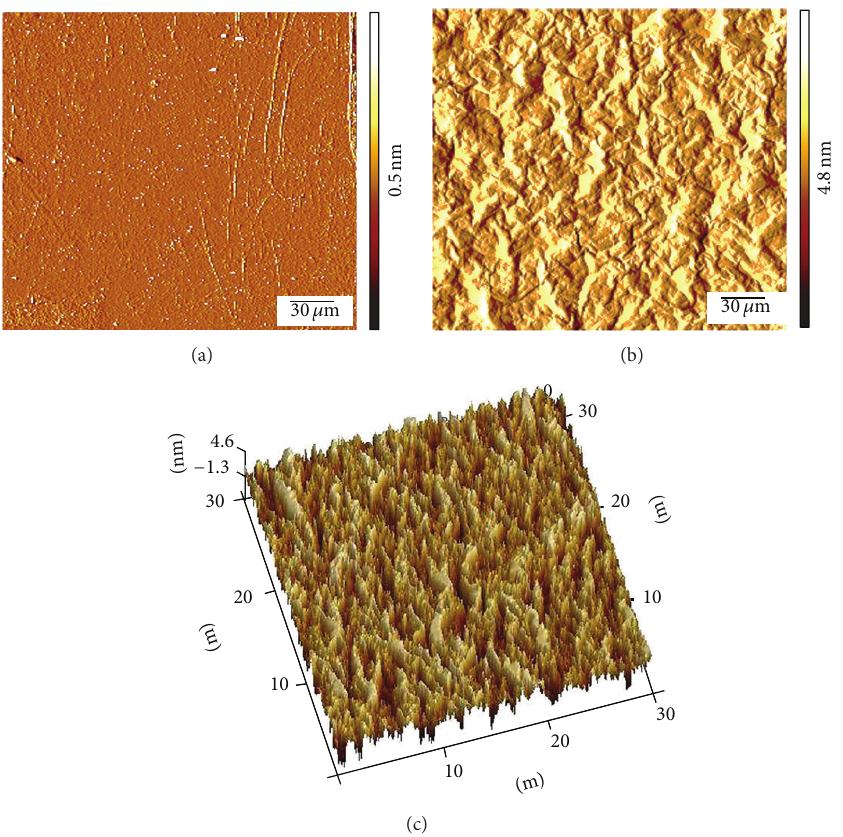
Figure 4: Characterization by atomic force microscopy of (a) CVD-grown graphene; (b) and (c) GO (10mg/mL).